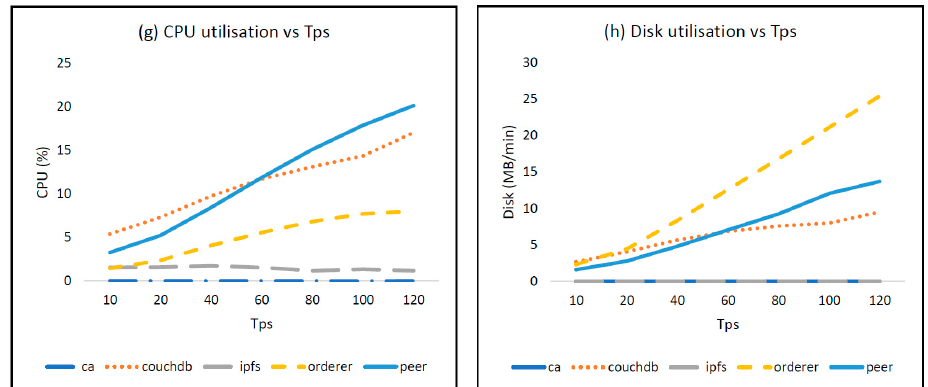
Figure 7. Analysis of writeOnchainData with different payload sizes and transactions/sec. ( a ) Latency vs. Payload’s size; ( b ) Memory utilisation vs. Payload’s size; ( c ) CPU utilisation vs. Payload’s size; ( d ) Disk utilisation vs. Payload’s size; ( e ) Latency vs. Tps; ( f ) Memory utilisation vs. Tps; ( g ) CPU utilisation vs. Tps; ( h ) Disk utilisation vs. Tps.